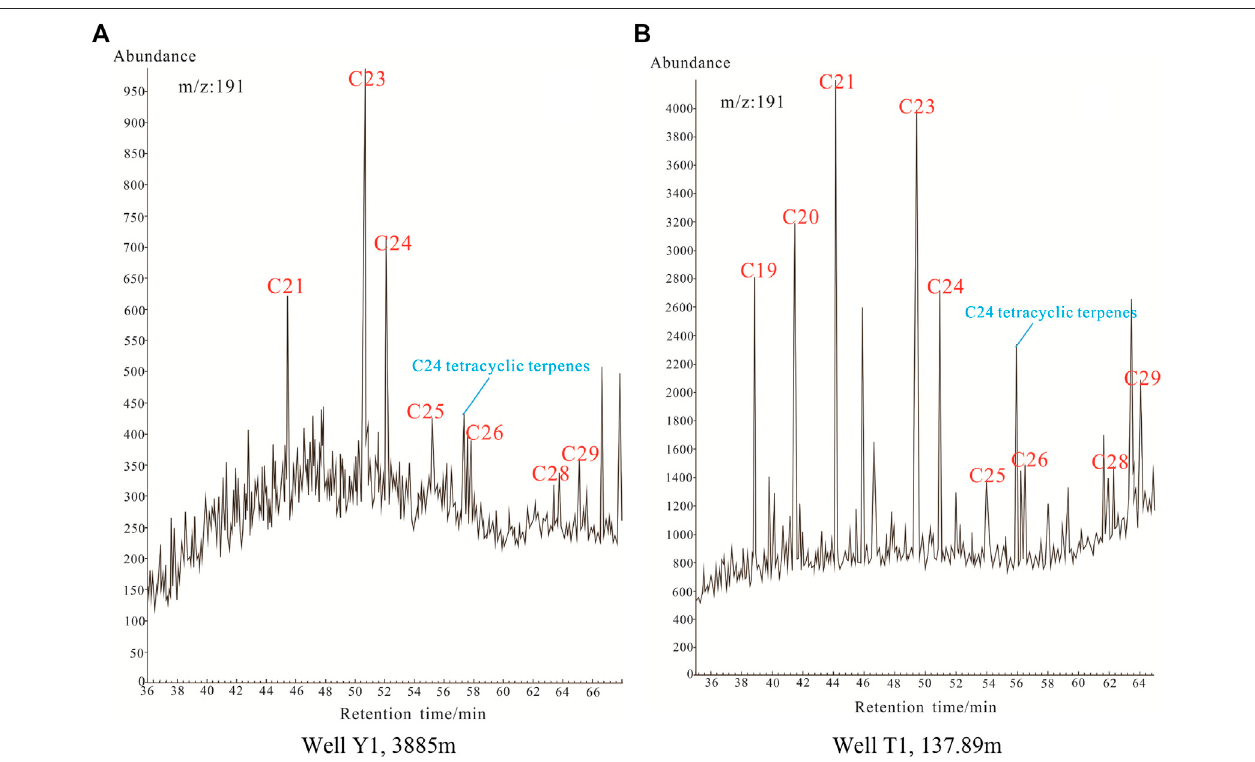
FIGURE 9 | Typical terpenoids chromatograms of J 1 da shale samples. (A) Well Y1, 3,885 m. (B) Well T1, 137.89 m.